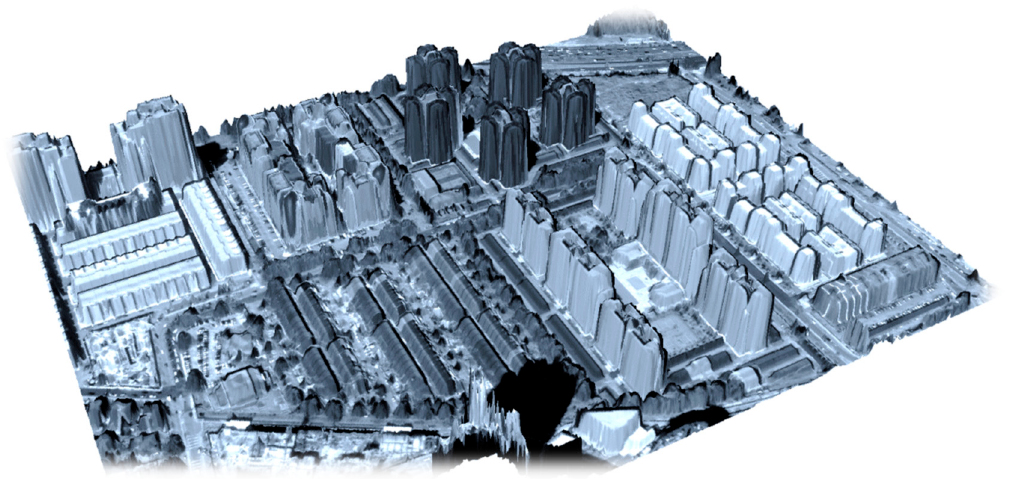
Figure 12. Orthorectified WV-3 image using 3D RCP model.